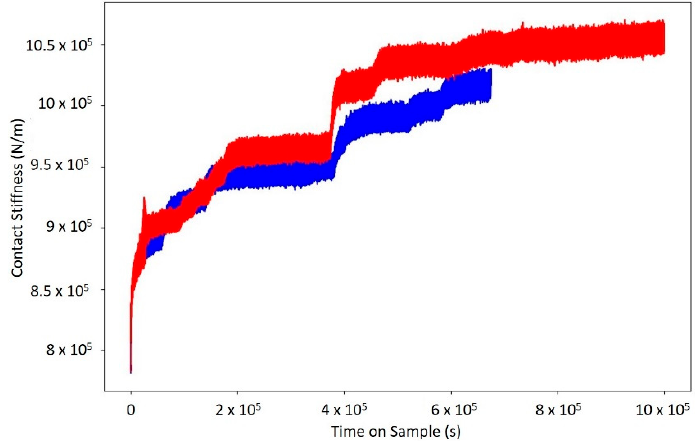
Figure 9. Plot of contact stiffness obtained via the CSM vs. time for two very long hold creep tests. Data in the first ~30,000 s are quantitatively similar to those from other experiments of shorter durations, but marked accelerations and decelerations in the creep rate are observed in both of these experiments at longer hold times.